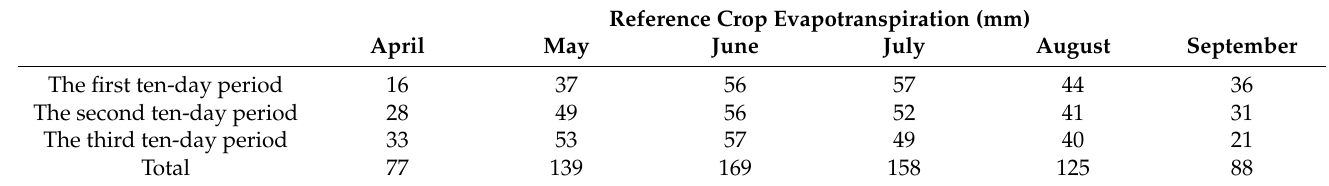
Table 2. Annual average reference crop evapotranspiration in the study area for different months between 2008–2018.